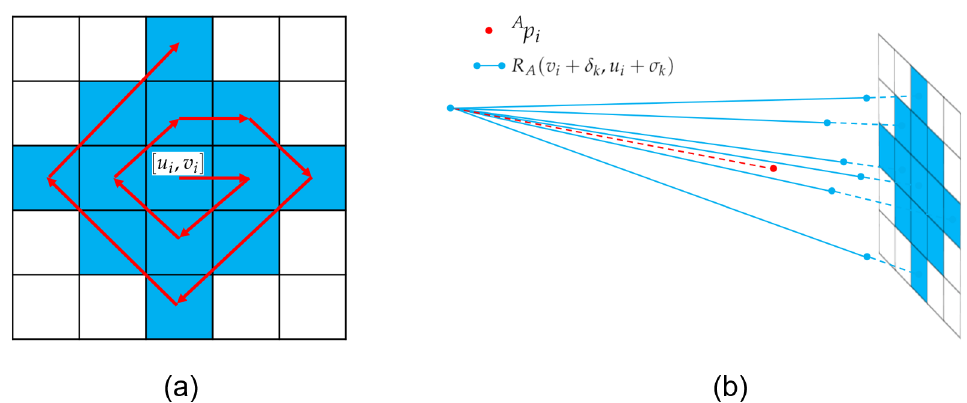
Figure 4. Due to relative pose error and the range image quantization error, the current observed point A p i should not merely be compared with R A ( v i , u i ) , but also a small area around [ u i , v i ] in the range image. Subfigure ( a ) shows the comparing order between the current observed point and the small area in the reference frame, while subfigure ( b ) shows an illustrative